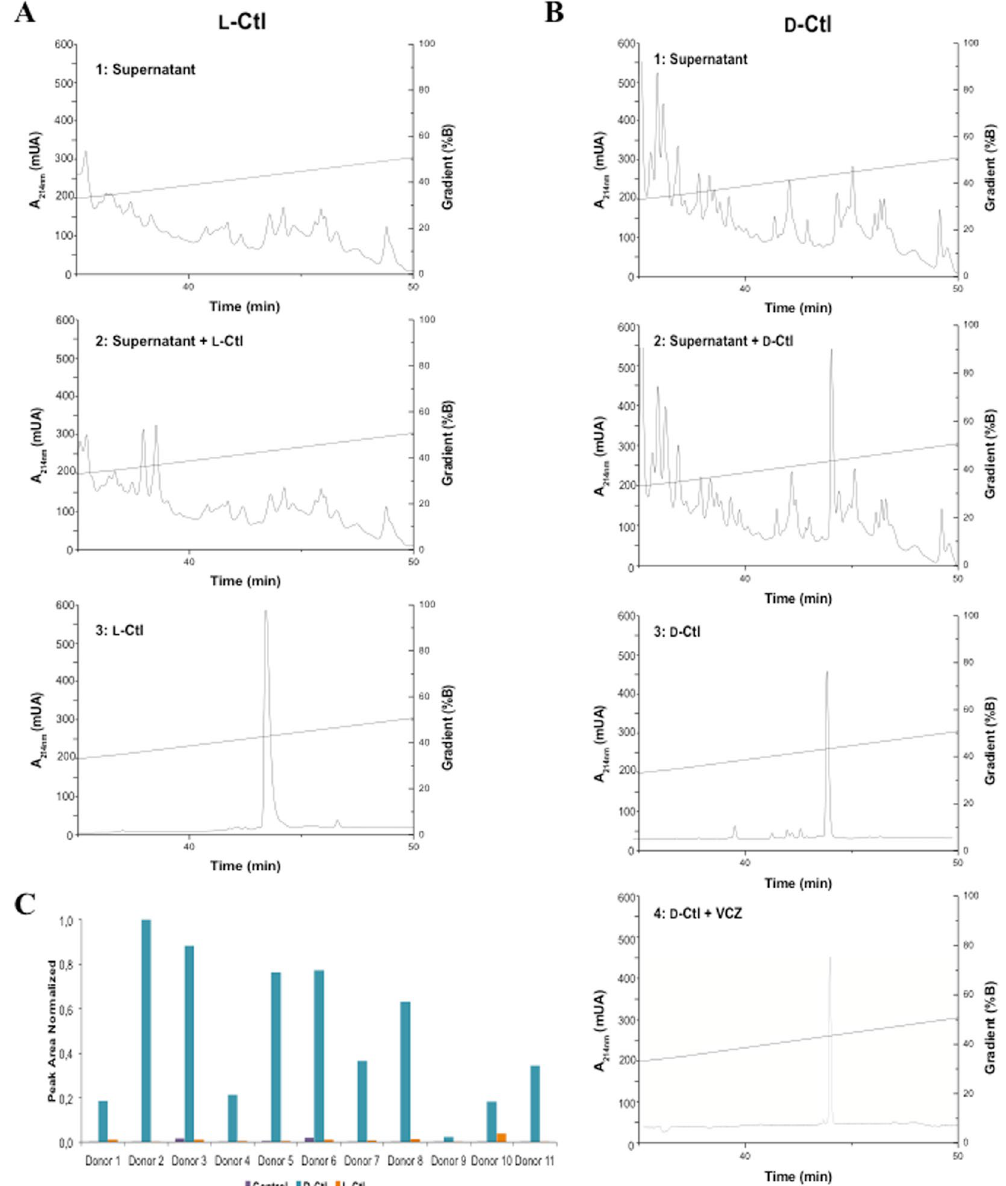
Figure 3. Stability of L-Ctl and D-Ctl in the supernatant of Candida albicans and in saliva. The supernatant of Candida albicans alone (chromatograms 1) or in the presence of the L-Ctl ( A ) or D-Ctl ( B ) (chromatograms 2) was directly incubated at 37 °C for 24 h prior being analysed by HPLC. As a control, each peptide (chromatograms 3) as well as the combination ½ MIC D-Ctl + ¼ MIC VCZ (chromatogram 4) were also incubated in water at 37 °C for 24 h. Each experiment was repeated three times. Saliva from 11 healthy volunteers was incubated with D-Ctl or L-Ctl for 24 hours and peptide stability was then assessed by LC-SRM ( C